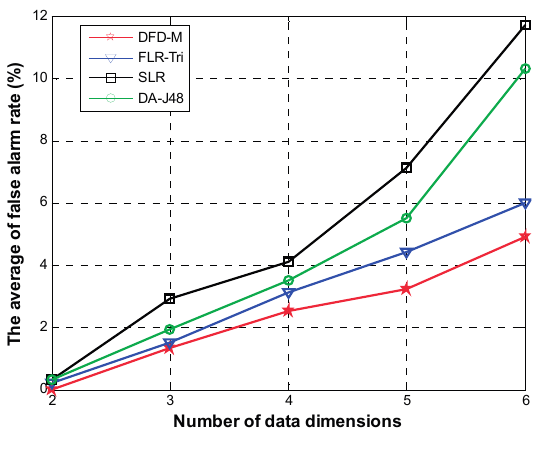
Figure 14. False alarm